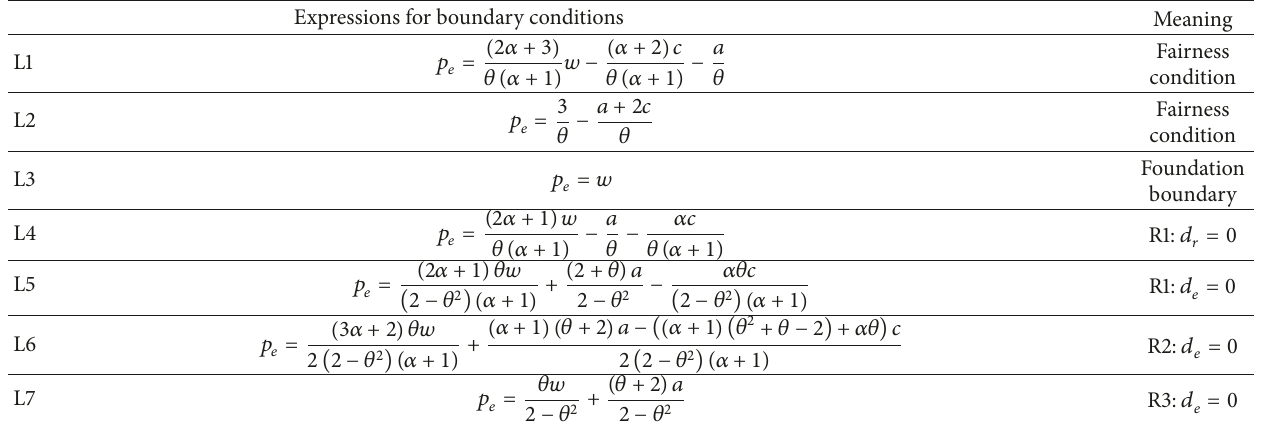
Table 3: The partial equilibrium strategies of the manufacturer in R2.